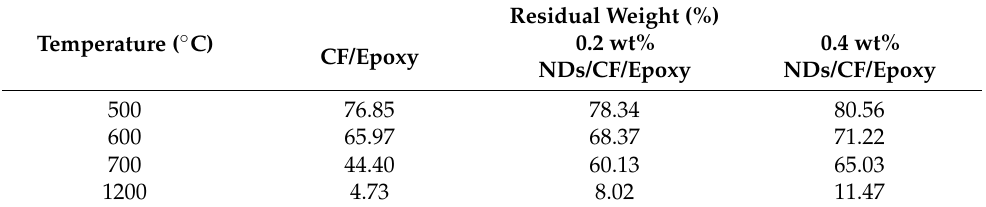
Figure 8. TGA curves depicting thermal response of (i) CF/epoxy composites (ii) CF/epoxy/0.2 wt% NDs, and (iii) CF/epoxy/0.4 wt% NDs. Table 2. Residual weight of composites at different temperatures.